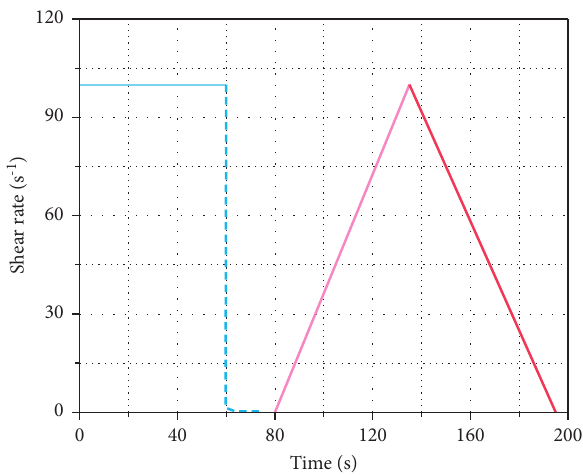
Figure 1: Schematic representation of the applied rheology